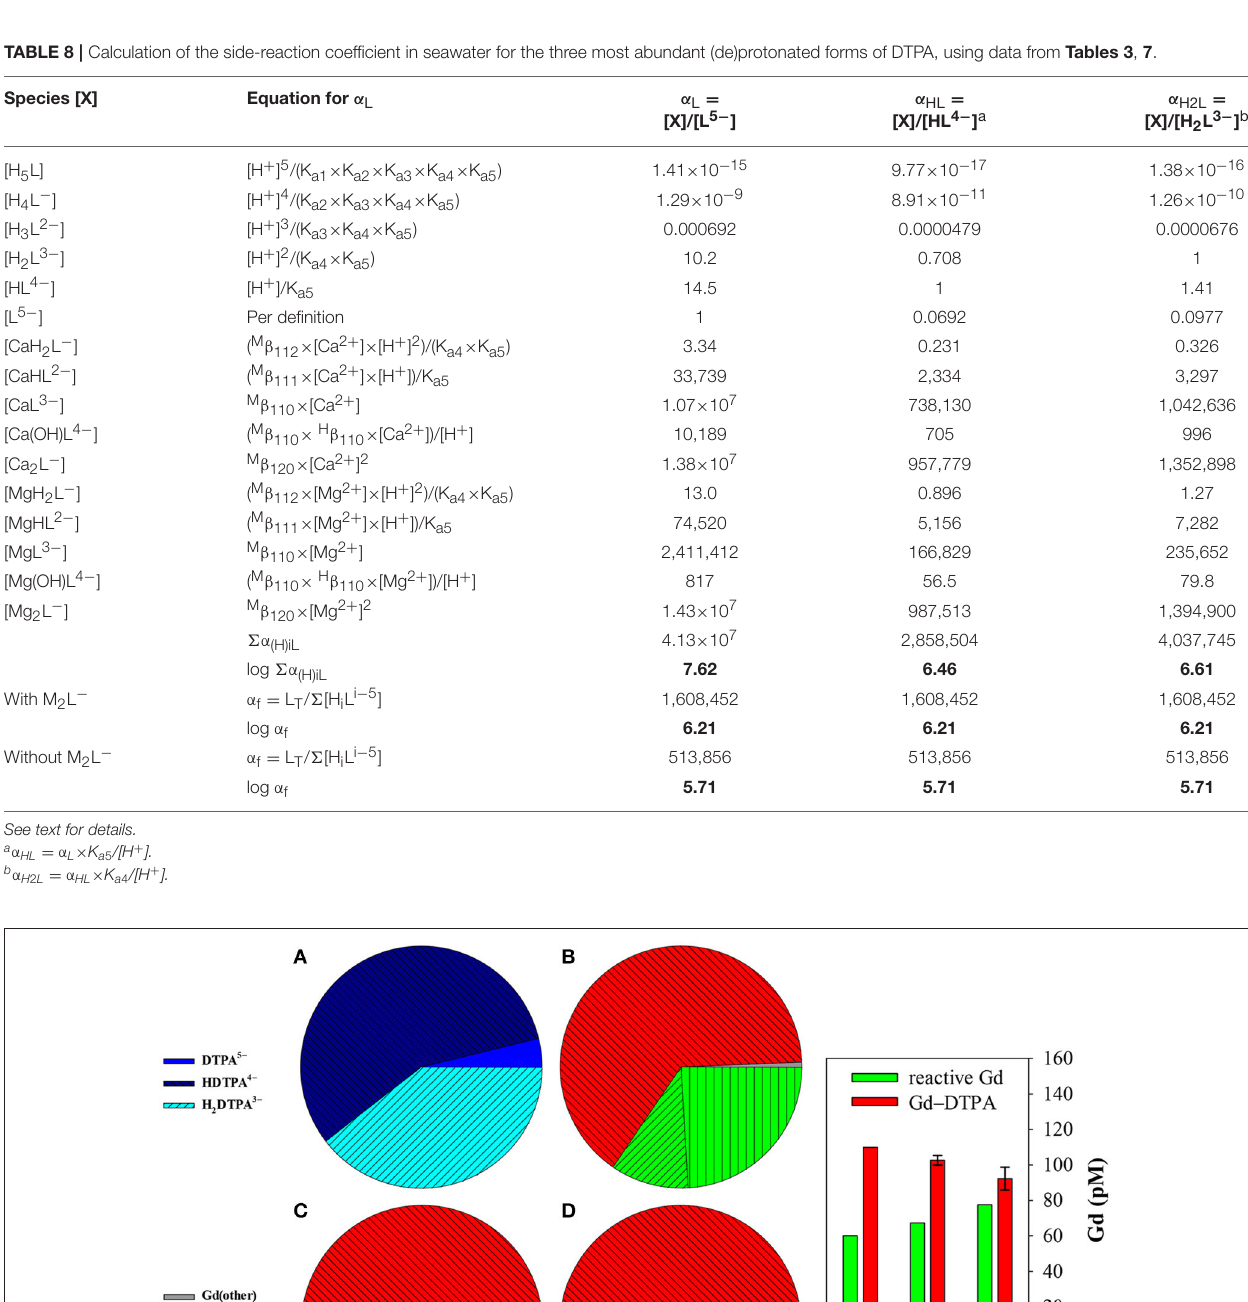
Frontiers in Marine Science |